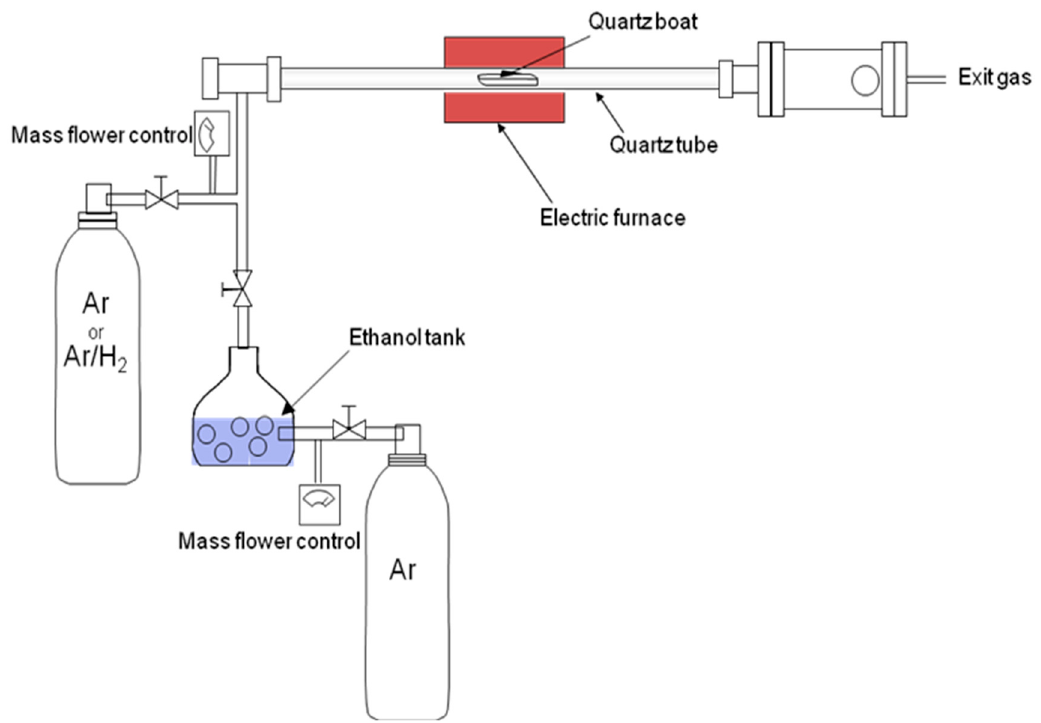
Figure 1. Diagram of the catalytic CVD system used for the growth of SWCNTs.